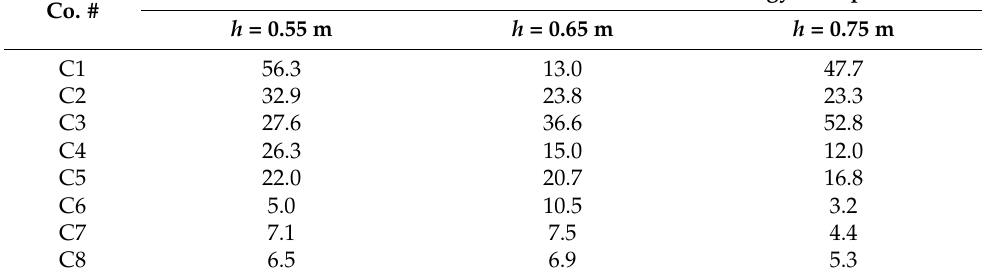
Table 5. Contribution of coral skeletons in the total wave-energy dissipation provided by the reef model.